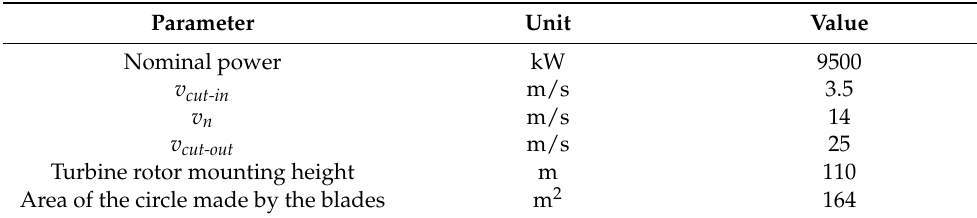
Table 1. Turbine V164-9.5MW parameters adapted from [43]. Parameter